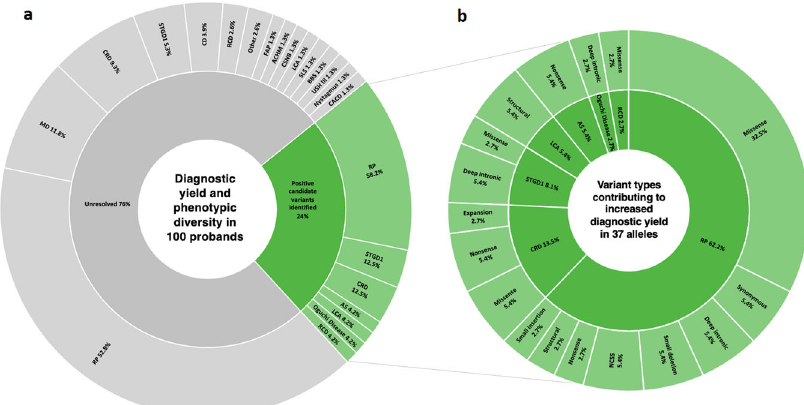
Fig. 1 Sunburst diagrams illustrating diagnostic yield, phenotypic diversity and variants contributing to increased diagnostic yield in this study. a Diagnostic yield and phenotypic diversity. The inner rings represent solved (green) and unresolved (gray) cases following whole- genome sequencing. The outer ring encompasses the phenotypic presentation of patients in these groups. b Variant types contributing to increased diagnostic yield. The types of variants contributing to increased diagnostic yield are illustrated on the outer ring, with their corresponding clinical phenotypes on the inner ring. ACHM achromatopsia, AS Alström syndrome, BBS Bardet – Biedl syndrome, CACD central areolar choroidal dystrophy, CD cone dystrophy, CRD cone – rod dystrophy, CSNB congenital stationary night blindness, FAP fundus albipunctatus, LCA Leber congenital amaurosis, MD macular dystrophy, NCSS noncanonical splice site, RCD rod – cone dystrophy, RP retinitis pigmentosa, SLS Senior – Loken syndrome, STGD1 Stargardt disease type 1, USH III Usher syndrome type III. Small insertions include insertions <4-bp in length. Small deletions include deletions <4-bp in